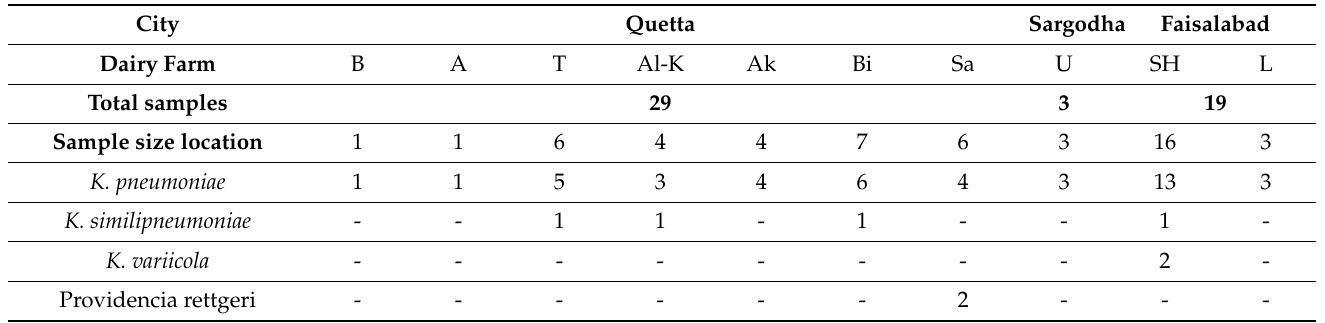
Table 1. Number of isolates corresponding to each species isolated from 10 different dairy farms in the cities of Quetta, Faisalabad and Sargodha in